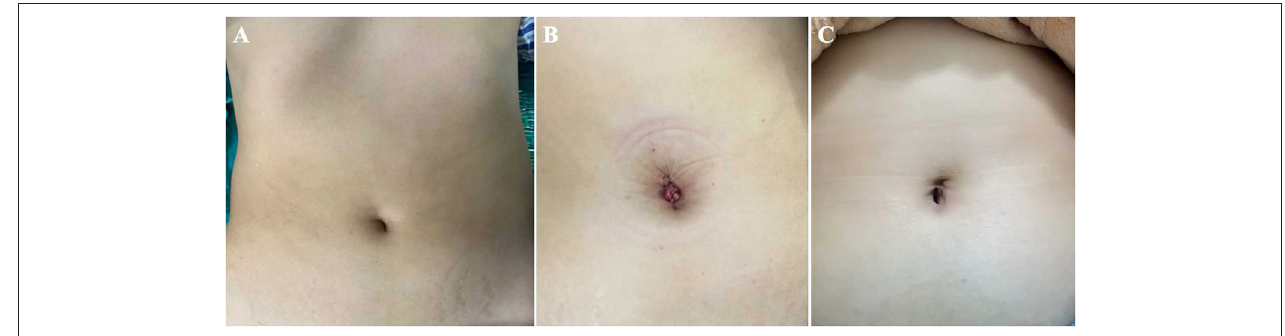
FIGURE 8 | The umbilical incisions of the TU-LESS extraperitoneal approach. (A) The preoperative appearance. (B) The postoperative appearance. (C) The appearance 3 months after surgery.